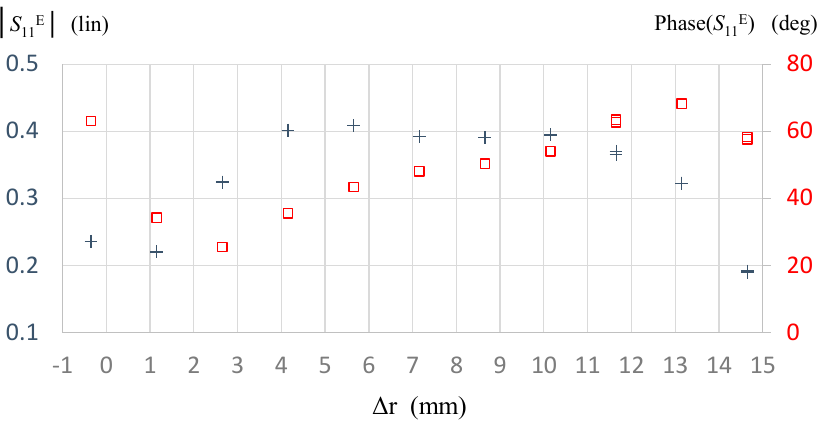
Figure 5. Measured empty free-space complex reflection coefficient S E as a function of the stand- off distance ∆ r from the reference plane (L r = 24.04 mm)—f = 10 GHz (+ amplitude | S 11 E | and (cid:3) Phase of S 11 E ).